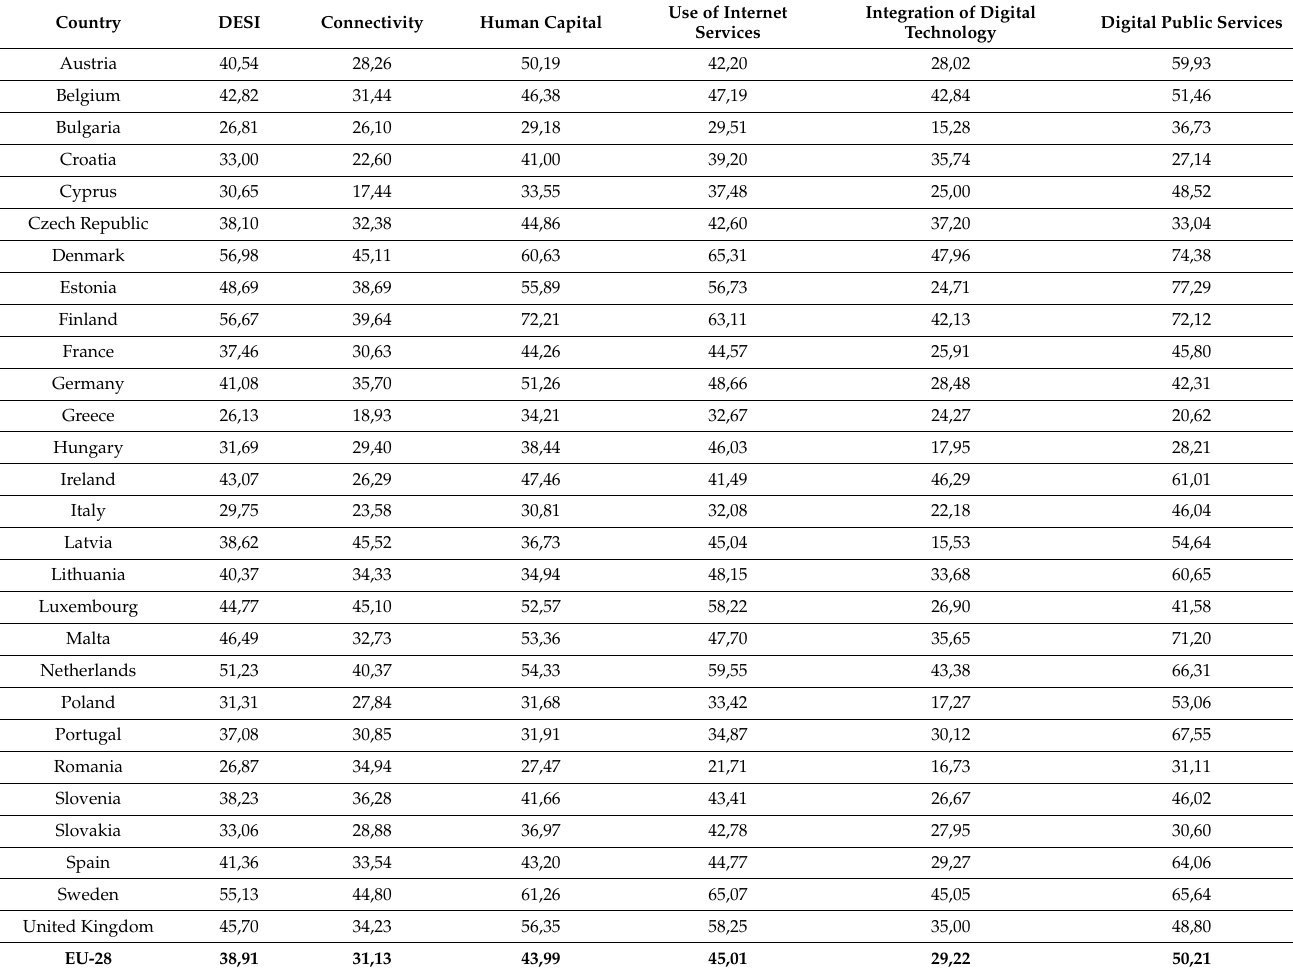
Table A1. Value of DESI and its subcomponents in 2015 in a cross-section of EU-28 countries